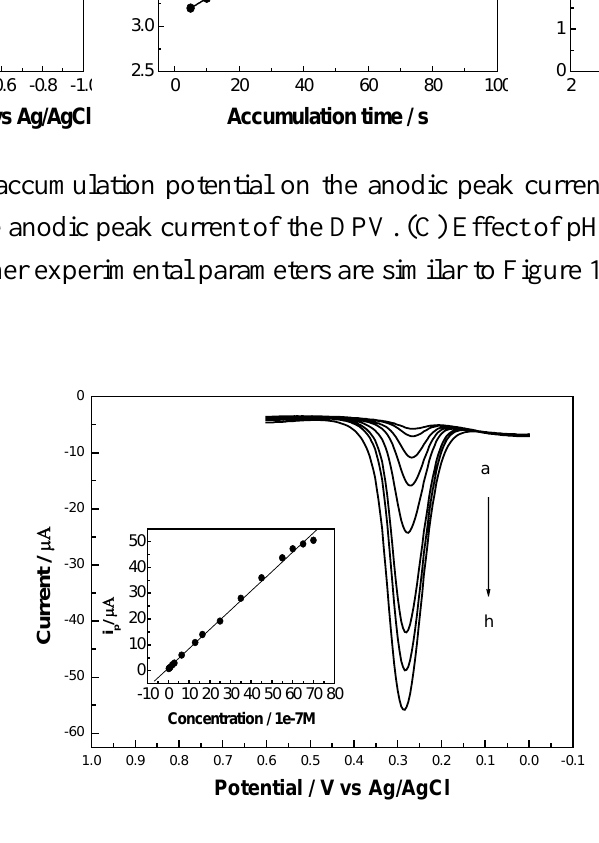
Figure 4. Differential pulse voltammograms of DA at the modified electrode in the PBS (0.025 M, pH 6.0). The concentrations of DA: (a) 6.0 × 10 -8 M ; (b) 2.0 × 10 -7 M ; (c) 6.5 × 10 -7 M ; (d) 1.3 × 10 -6 M ; (e) 2.5 × 10 -6 M ; (f) 4.5 × 10 -6 M; (g) 5.5 × 10 -6 M ; (h) 6.5 × 10 -6 M. Inset: Plot of the anodic